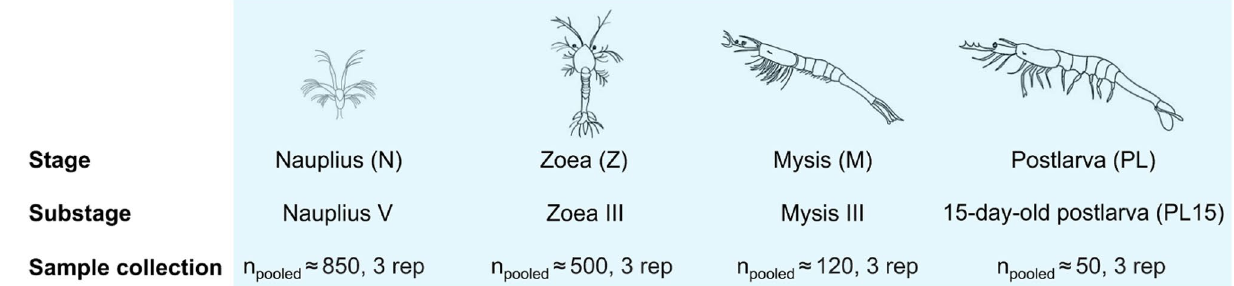
Figure 1. Schematic diagram of larval stages during early development of P. monodon collection. Shrimp samples were collected at stages of nauplius (N), zoea (Z), mysis (M) and 15-day-old postlarva (PL15) for transcriptome